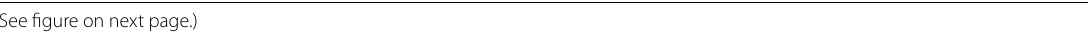
(See figure on next page.) Fig. 5 a , b , c MRI axial and coronal T2 WI images showing left anterior intersphincteric fluid filled fistulous tract with fibrotic wall (yellow arrows) seen ending cranially with small intersphincteric collection abutting the internal sphincter at 12–2 o’clock (blue arrows). d A side branch of high STIR signal is seen arising from the intersphincteric collection abutting the left aspect of the rectum. e , f , h Axial and post reconstruction coronal ultrasound images show left anterior intersphincteric hypoechoic fistulous tract (yellow arrow) seen ending with left intersphincteric collection showing internal echogenic foci /air (abscess) breaching the internal sphincter at 12–2 o’clock (blue arrow). g Ultrasound axial image show hypoechoic side branch arise from the intersphincteric collection and runs posteriorly (red